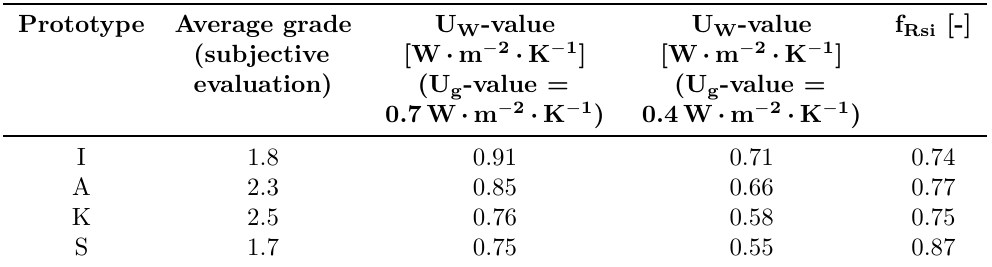
Table 1. Evaluation results (average grade), U